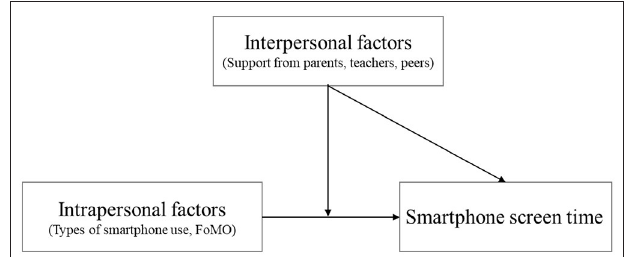
FIGURE 1 | Theoretical